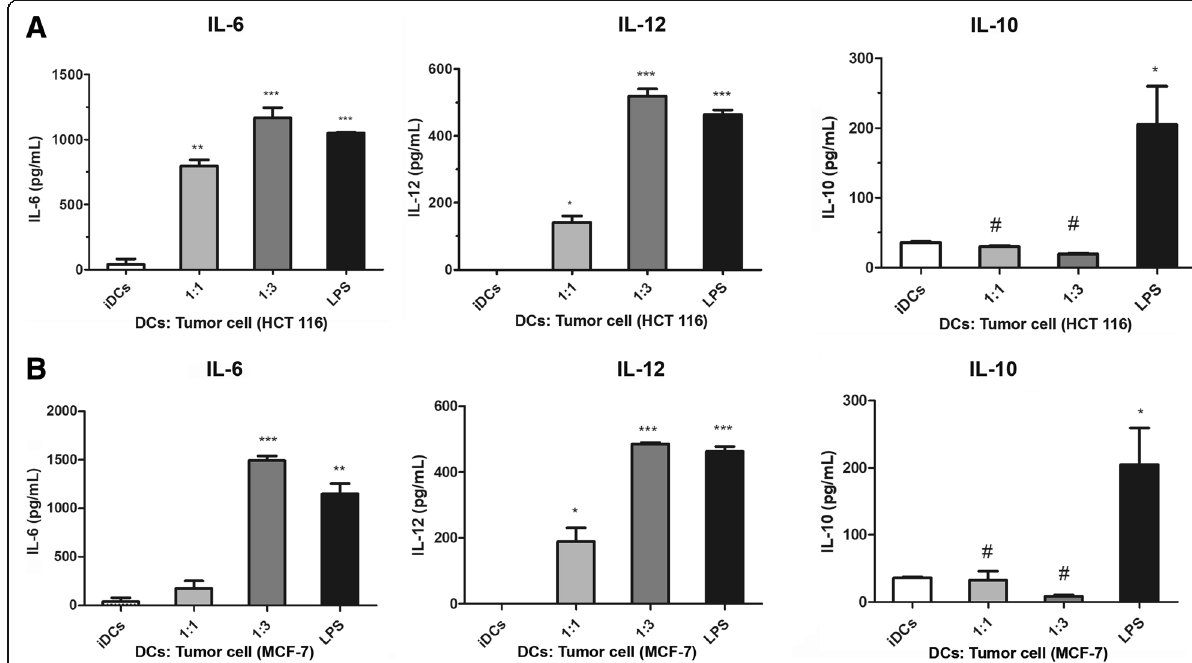
Fig. 5 Increase of IL-12 P40, IL-6, and decrease of IL-10 cytokines release by tumor lysate-loaded dendritic cells. ELISA was used to quantify the cytokines concentrations in the supernatants of unloaded DCs, a HCT116-TLY-pulsed DCs, b MCF-7-TLY-pulsed DCs and LPS-only-stimulated DCs. Each point represents the mean±SEM of three independent experiments comprising three different healthy donors. The data were statistically analyzed by one-way ANOVA followed by Dunnett ’ s test * P < 0.05, ** P < 0.01, *** P < 0.001. DCs, dendritic cells; TLY, tumor lysate; ELISA; enzyme-linked